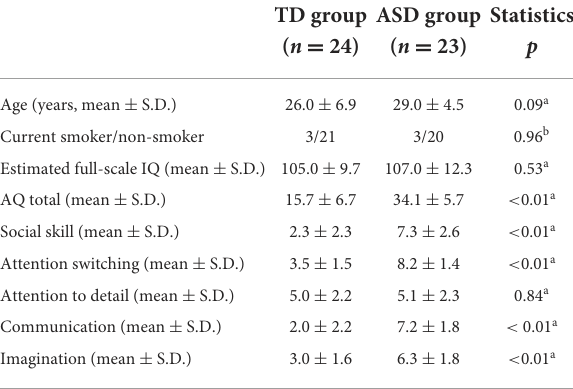
TABLE 1 Demographic and clinical characteristics of